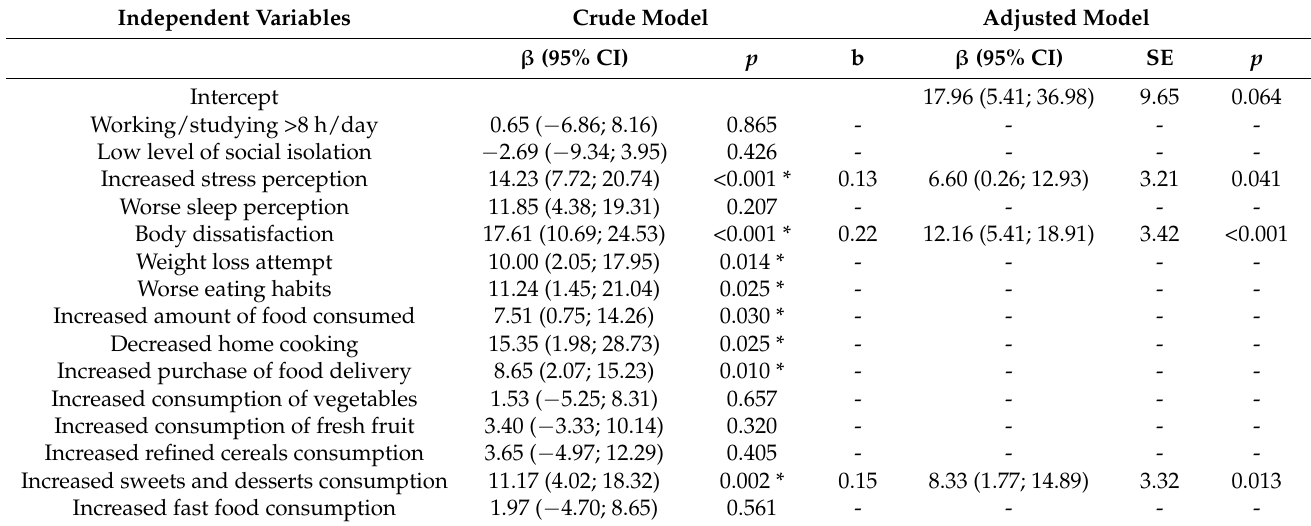
Table 3. Regression analysis of independent variables in relation to emotional eating of active group ( n = 220).